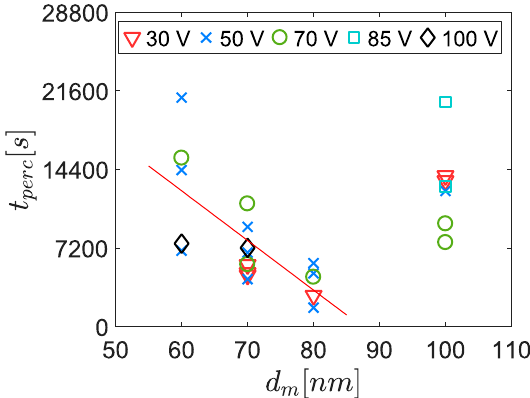
. . Figure 8. Overview of the percolation time for different mobility diameters and concentrations. The Figure 8. Overview of the percolation time for different mobility diameters and concentrations. The red red line is the correlation between the averaged percolation times and the mobility diameters, line is the correlation between the averaged percolation times and the mobility diameters, without Figure 8. Overview of the percolation time for different mobility diameters and concentrations. The without taking into account the 100 nm diameter measurements ( 𝑡 (cid:3043)(cid:3032)(cid:3045)(cid:3030) = −455 × 𝑑 (cid:3040) + 39737 , 𝑅 (cid:2870) = taking into account the 100 nm diameter measurements ( t perc = − 455 × d m + 39737, R 2 = 0.9463). red line is the correlation between the averaged percolation times and the mobility diameters, 0.9463 ). without taking into account the 100 nm diameter measurements ( 𝑡 (cid:3043)(cid:3032)(cid:3045)(cid:3030) = −455 × 𝑑 (cid:3040) + 39737 , 𝑅 (cid:2870) = 0.9463 ).